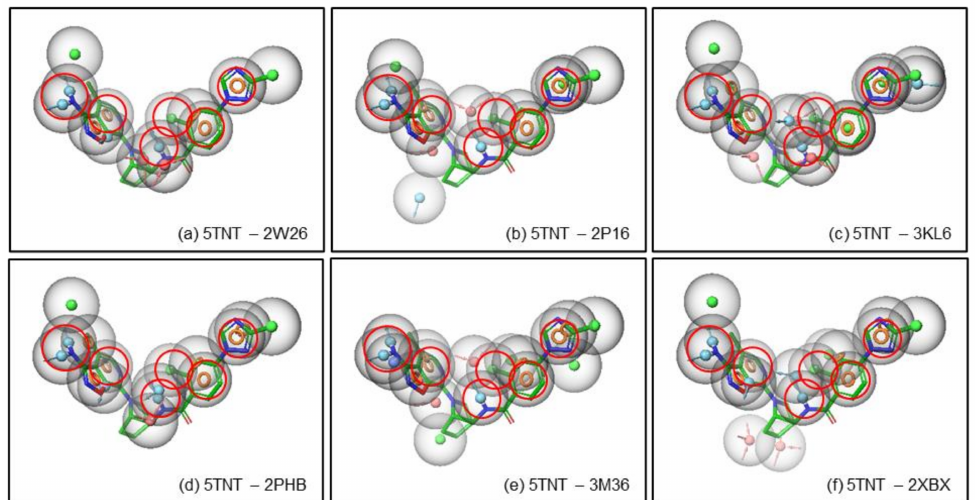
Figure 7. Pharmacophore based criteria is shown for potency and selectivity. The pharmacophoric descriptions are represented for potency ( a ), selectivity ( b ) and both together ( c ) for FIXa. Similarly, the pharmacophoric descriptions are represented for potency ( d ), selectivity ( e ) and both together ( f ) for FXa. The pharmacophoric features are represented by colored spheres: H-bond donor in blue, H-bond acceptor in pink, hydrophobic in green and aromatic ring in orange ring.